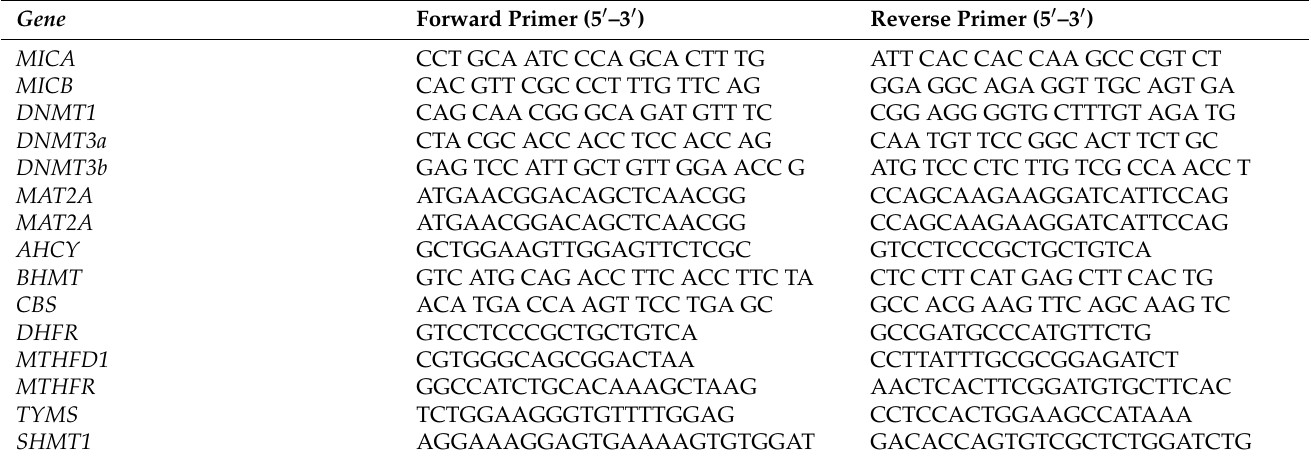
Table 1. List of qRT-PCR